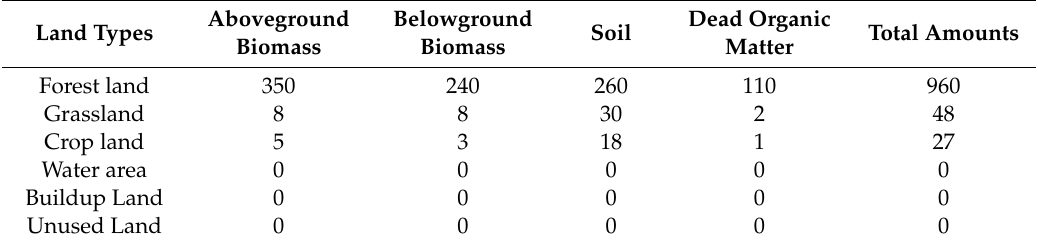
Table A3. Biomass in Shanghai estimated from [32] (tonnes / ha).